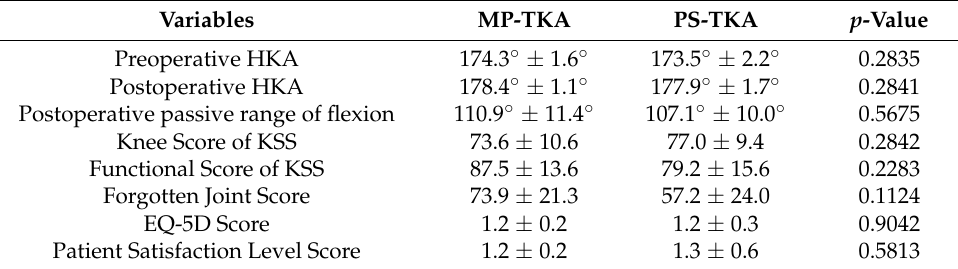
Table 2. Patient clinical outcome